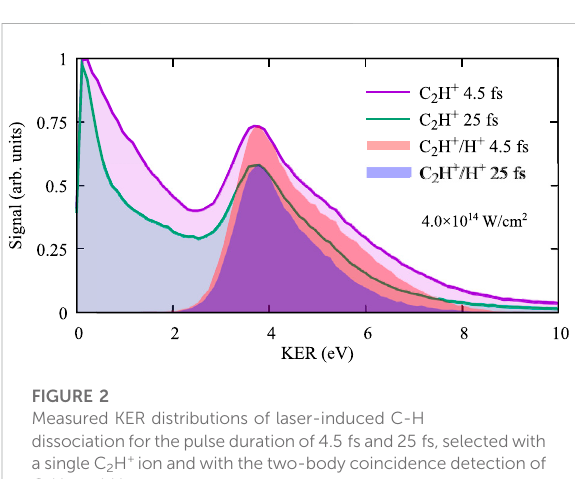
FIGURE 2 Measured KER distributions of laser-induced C-H dissociationforthepulsedurationof4.5 fsand25 fs,selectedwith a single C 2 H + ion and with the two-body coincidence detection of C 2 H + and H +